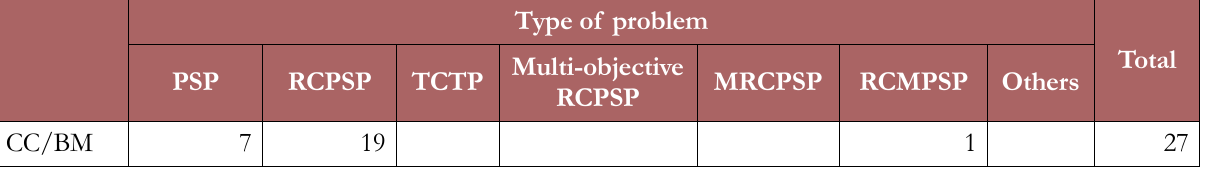
Table 8. Critical Chain and Buffer Management applied per type of problem